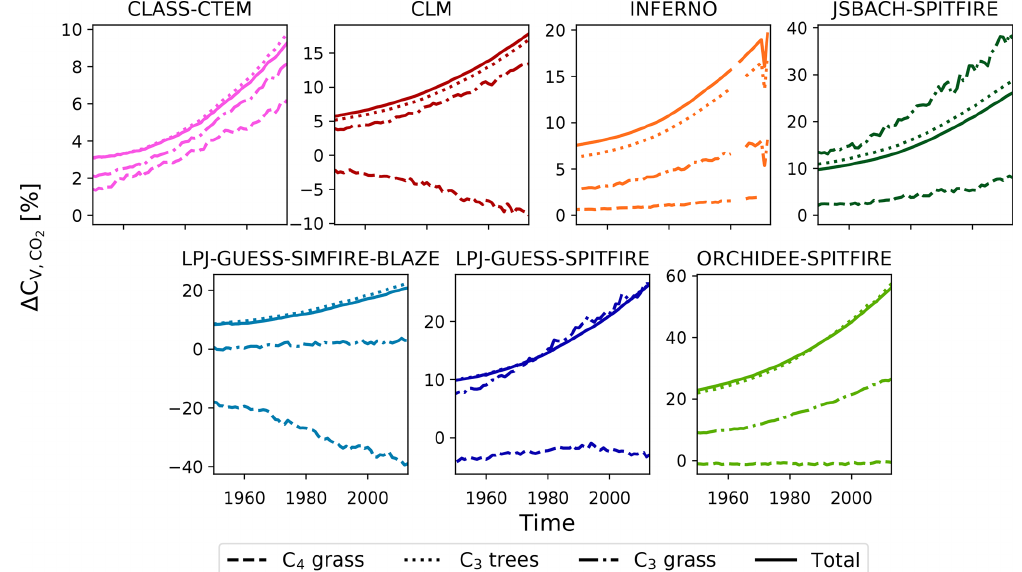
Figure 4. Relative difference in global carbon stored in C 4 grasses (dashed lines), in C 3 trees (dotted lines), in C 3 grasses (dash-dotted lines) and in total global carbon stored in vegetation (solid lines) between the baseline experiment SF1 and the sensitivity experiment SF2_CO2 (see Table 1; C V , CO ) for 1950–2013 in percent (annual averages). C 4 and C 3 grasses, as well as C 3 trees, only include natural PFTs (pastures 2 and croplands excluded). Note that the y axis limits differ between the panels. Due to a postprocessing error, INFERNO lacks 2 years (2001 and 2002).